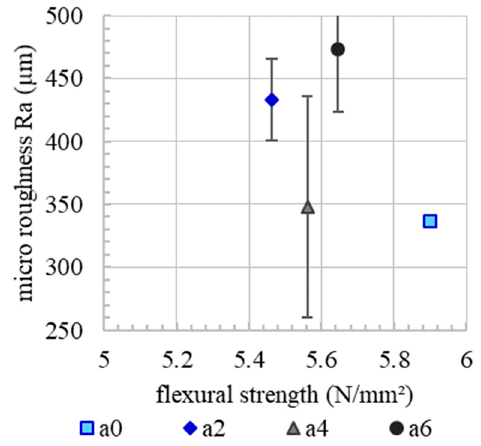
Figure 11. No correlation between initial micro roughness and flexural strength of an interlayer time of 0 min.